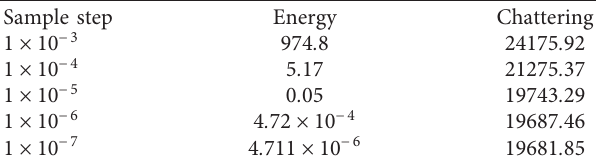
Table 2: Energy and chattering analysis for the FOSM controller. Sample